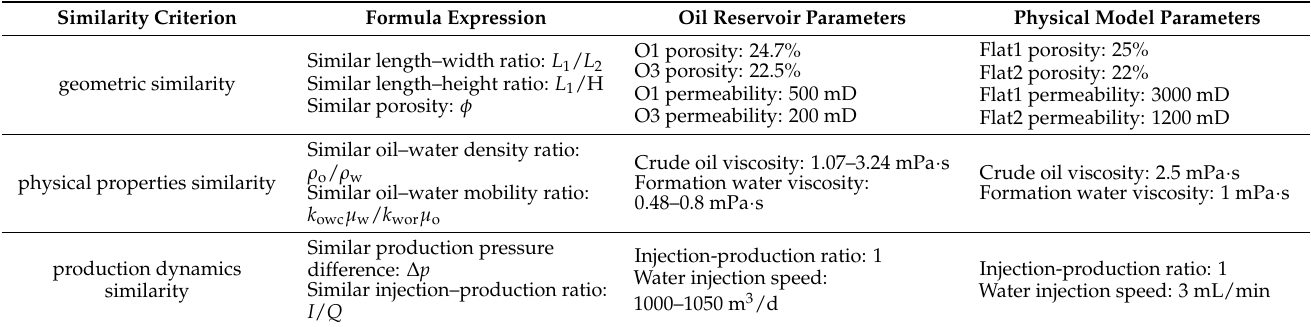
Table 2. Oil reservoir and laboratory experiment parameter table.